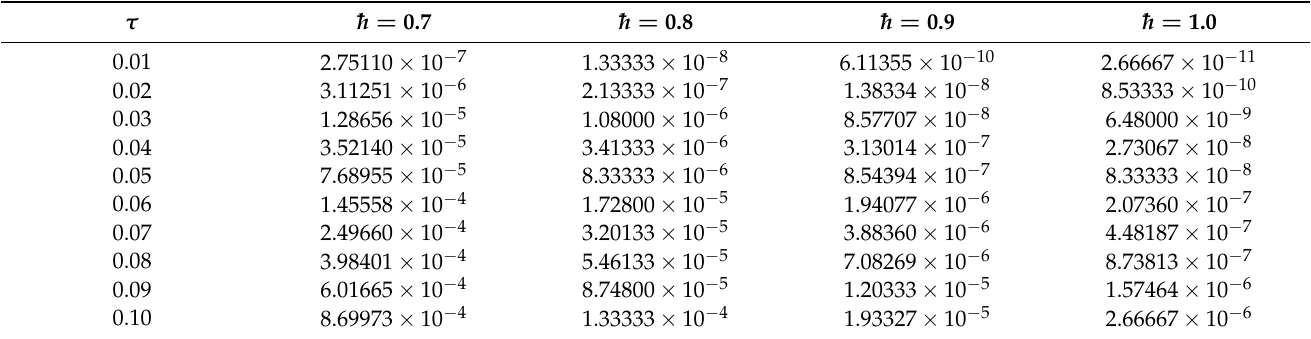
Table 8. The | Ω 5 ( α , τ ) − Ω 4 ( α , τ ) | of Problem 4.3 at varying values of ¯ h at α = 0.002 when ξ = 2.0 determined by the ARPSM at plausible locations in the range τ ∈ [ 0, 0.10 ] .